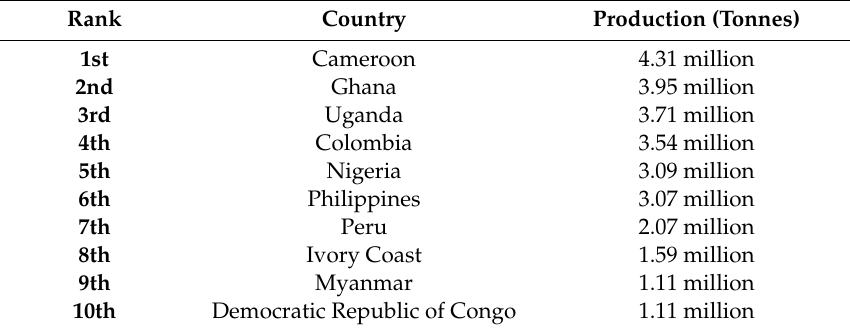
Figure 23. Global production of banana showing dominant banana output in the Asian, American and African continents [212]. Table 4. The Major Global Producers of Plantain ( Musa paradisiaca